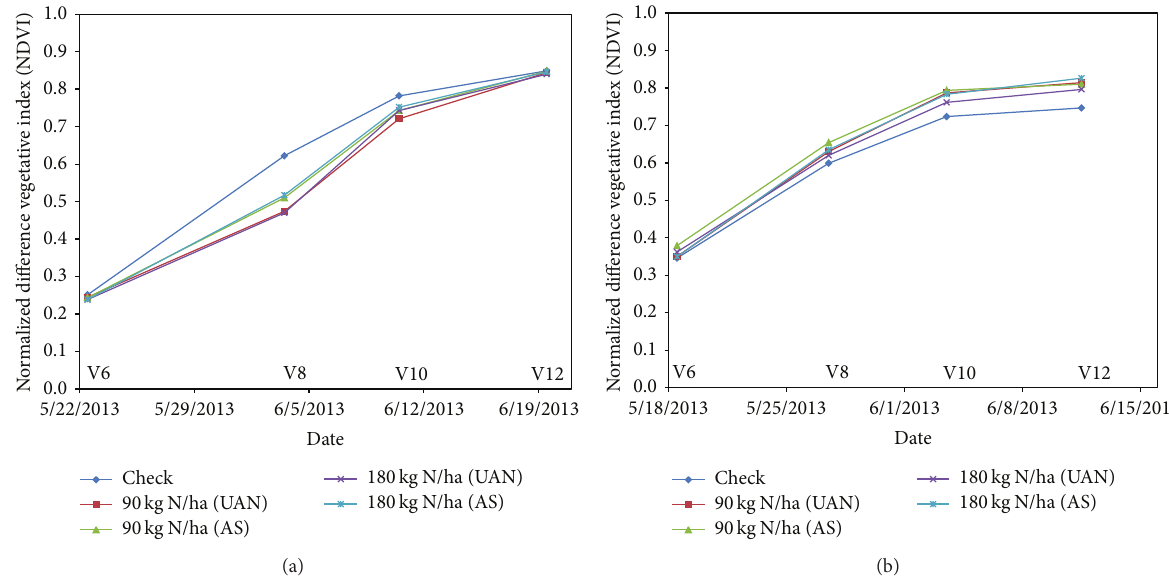
Figure 3: Normalized difference vegetative index (NDVI) values by maize growth stage, pooled across the main effect of irrigation, for Stillwater, OK (a) and Lake Carl Blackwell, OK (b) fertilizer treatments for the 2013 growing season.